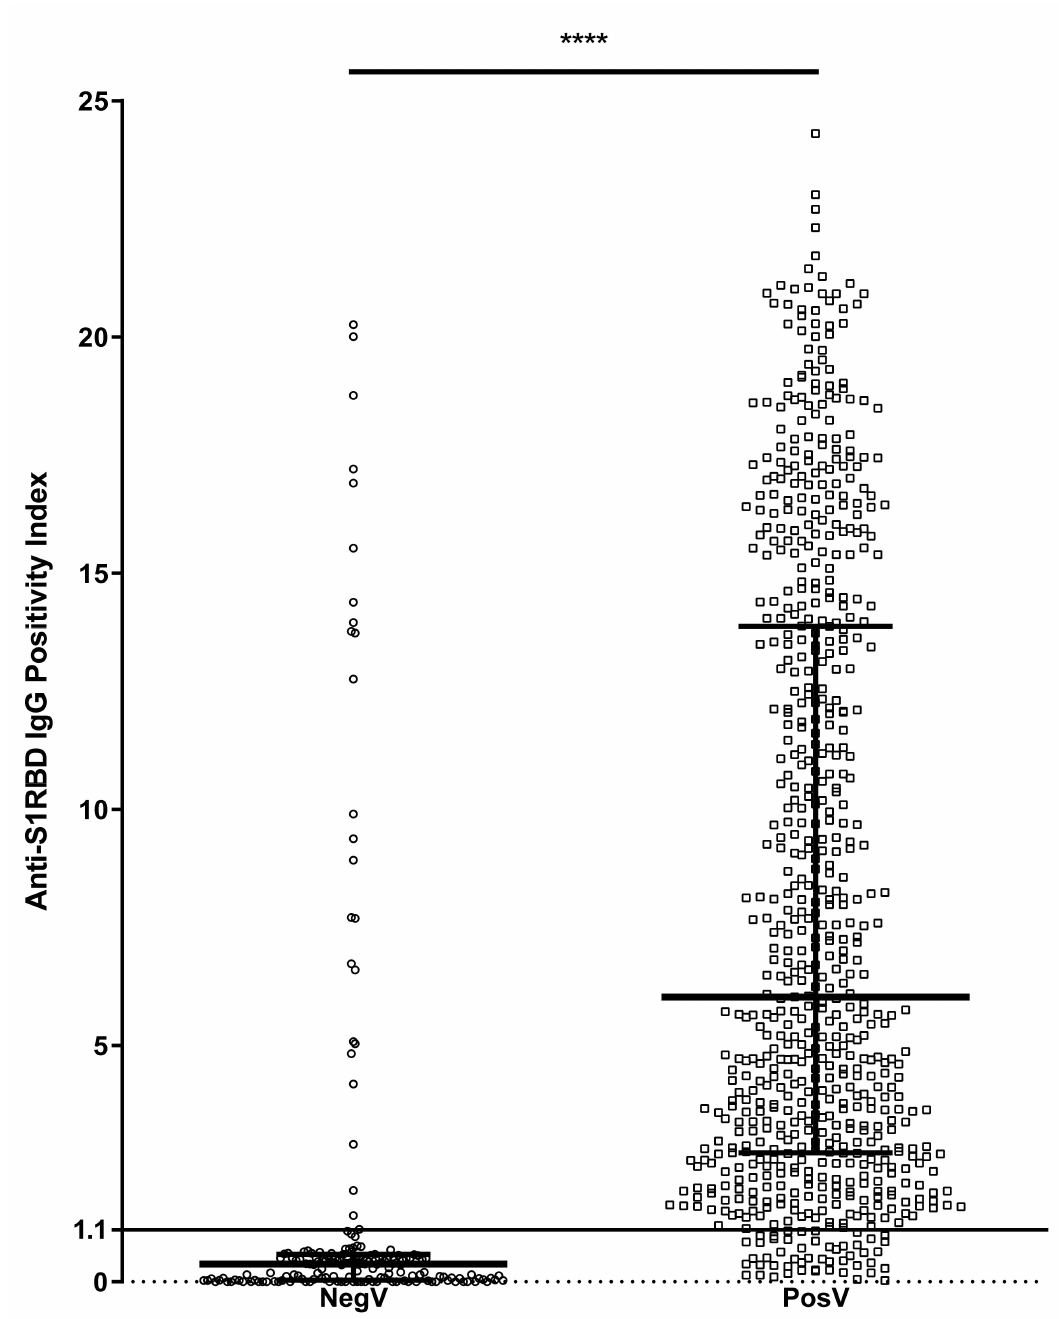
Figure 2. Distribution of positivity index (P.I.) of anti-S1RBD IgG antibodies between nega- tive/untested volunteers (NegV) ( n = 194) and SARS-CoV-2-positive volunteers (PosV) ( n = 695). The line at P.I. = 1.1 represents the threshold above which samples are considered positive. Bars represent median and interquartile ranges. **** p <